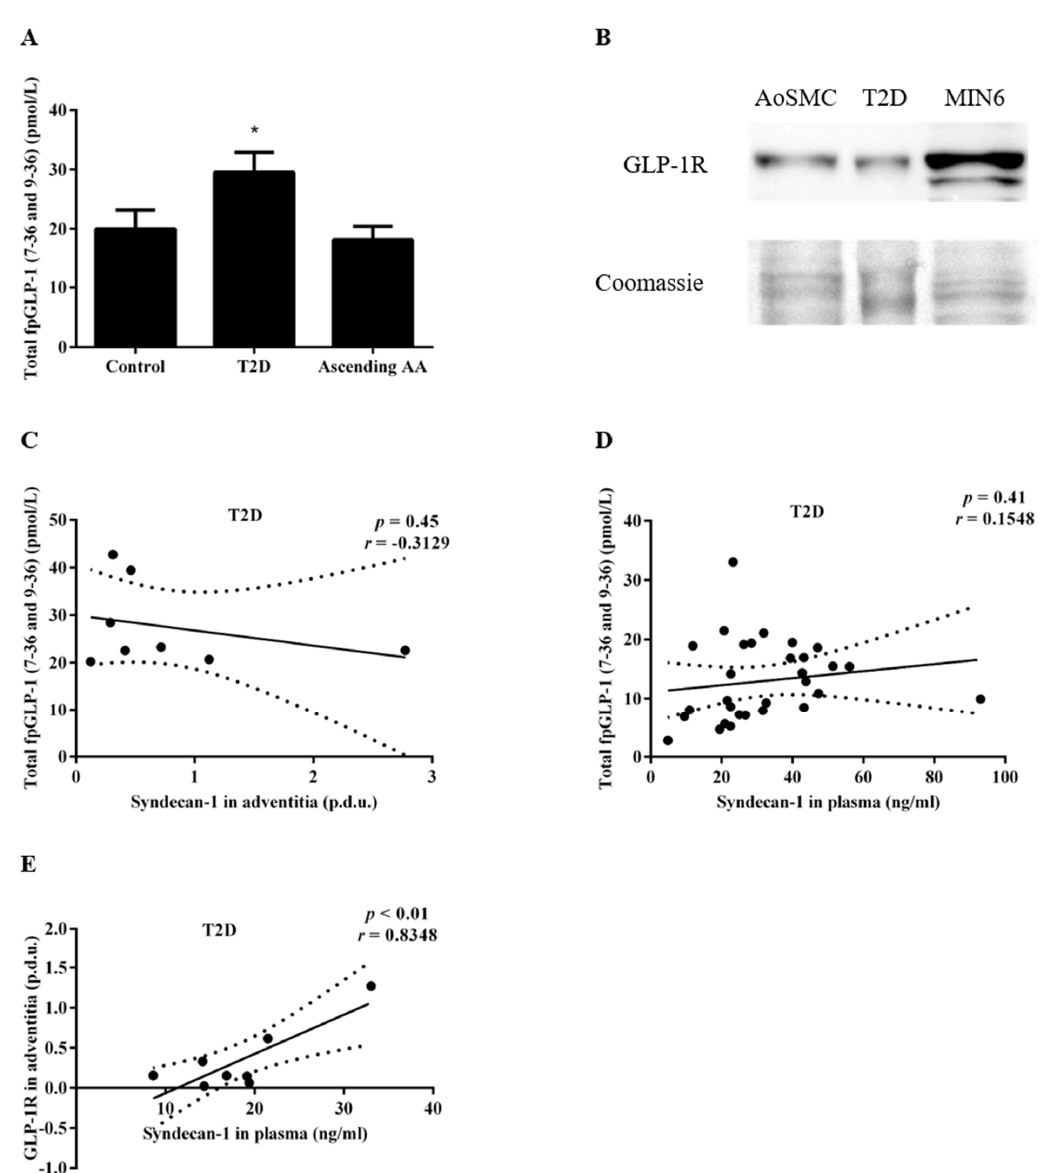
Figure 3. Increased fpGLP-1 in T2D was not significantly associated with the increased Sdc-1 expression in the adventitia of patients with T2D. ( A ) fpGLP-1 levels were upregulated in the T2D group of this study. ( B ) GLP-1R was detected in the adventitia of T2D patients. MIN6 cells and human aortic SMCs were used as a control and the bands were normalized with Coomassie Brilliant Blue (the full-length blot is provided in Supplementary Material Figure S3). ( C ) Sdc-1 in the adventitia was not associated with total fpGLP-1 in T2D patients and ( D ) the total fpGLP-1 was not associated with plasma Sdc-1 in patients with T2D. However, ( E ) the Sdc-1 in plasma was positively associated with GLP-1R in the adventitia ( n = 10). A Pearson correlation was used to assess any potential associations. Comparisons between the groups were made using a one-sided unpaired t-test. For plasma, n = 36 for the control and n = 30 for T2D; for tissue, n = 10 for the control and n = 9 for T2D. * p < 0.05.